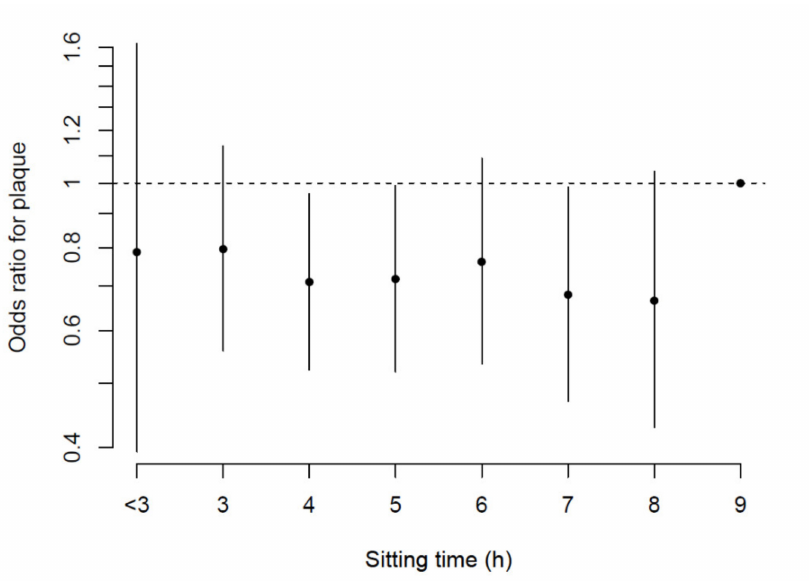
Figure 1. Odds Ratio (95%CI) for the presence of plaque in any of the analyzed territories (carotid and femoral) in terms of total hours of sitting time in the